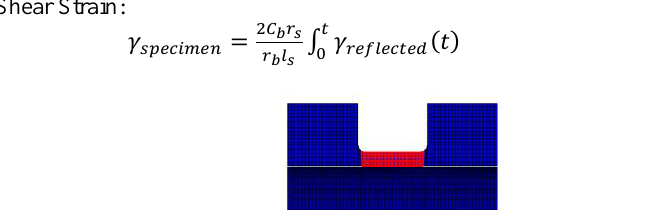
Fig. 9. Specimen elements for computing direct shear stress-shear strain